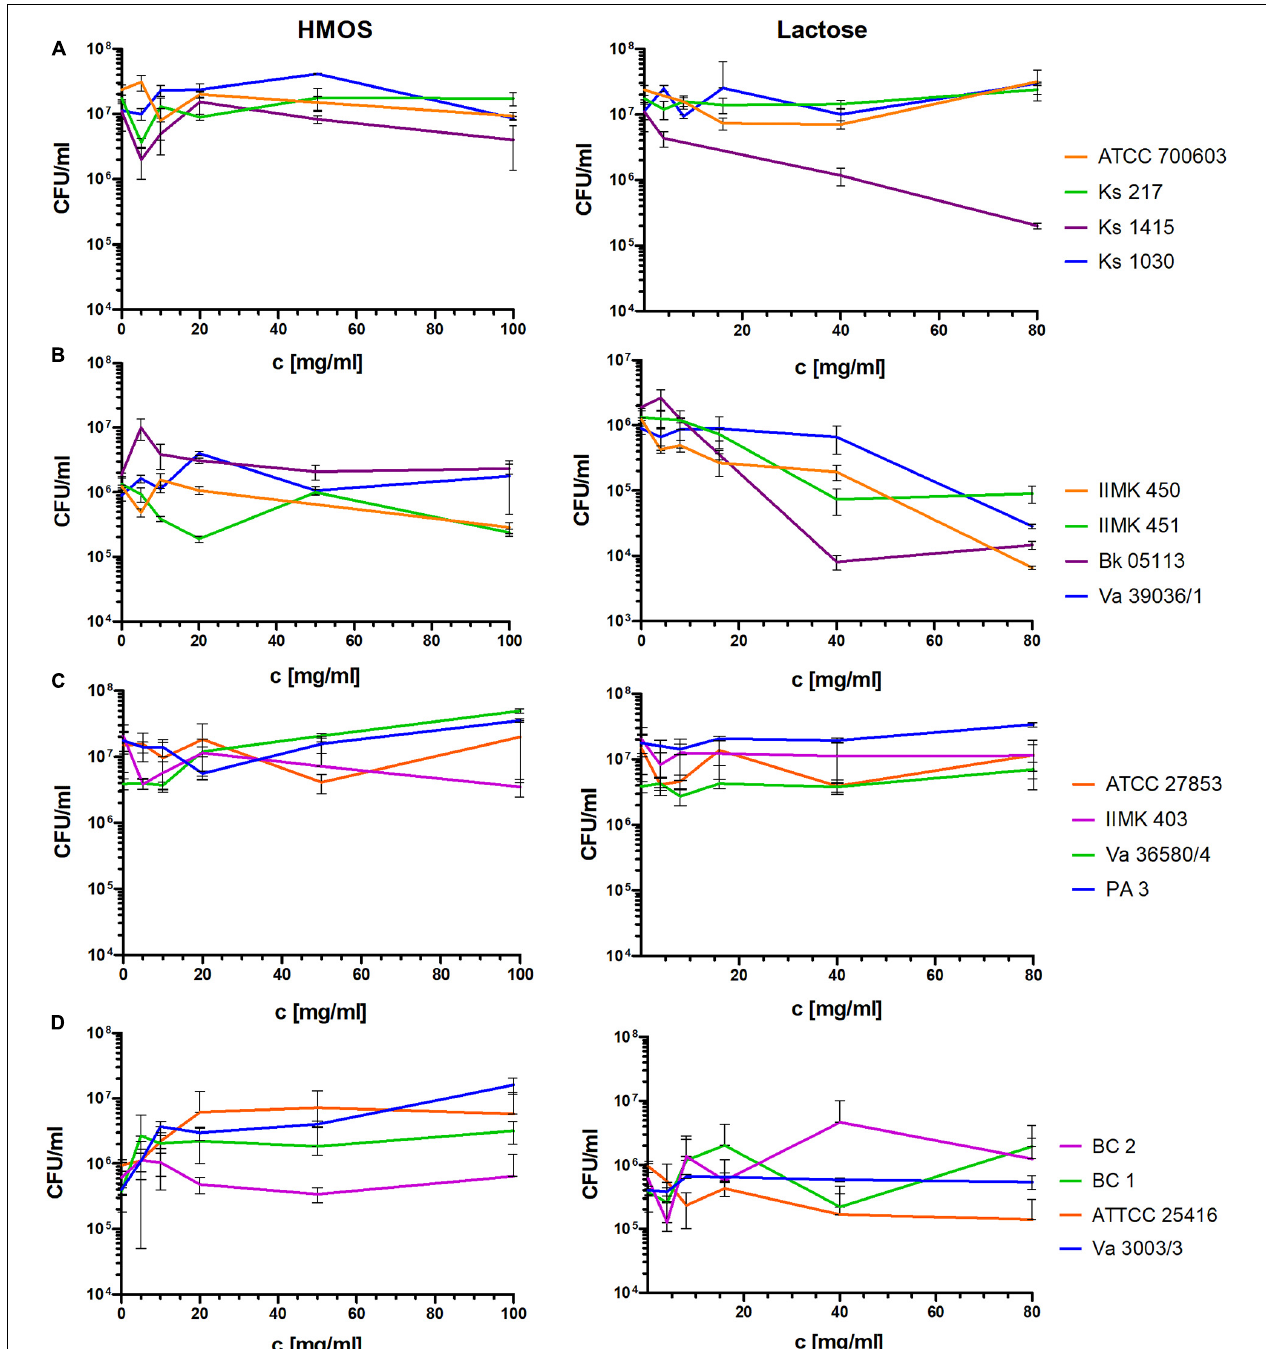
FIGURE 3 | Determination of the viable cell fraction (as CFUs/ml) in biofilms of laboratory and clinical strains of different Gram-negative species after treatment with the total HMOs and lactose in corresponding concentrations (assuming that lactose makes up to 80% of the HMOs) for 24 h. (A) K. pneumoniae , (B) A. baumannii , (C) P. aeruginosa , (D) B. cenocepacia